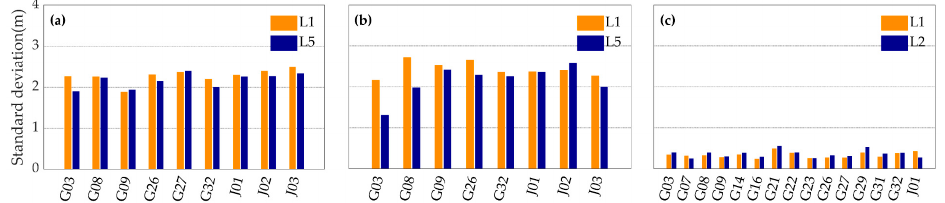
Figure 9. The standard deviations of L1 (orange), L5 or L2 (blue) code multipath errors with the Mate30 ( a ), the V20 ( b ) and the Trimble R8 ( c ) in the first experiment.